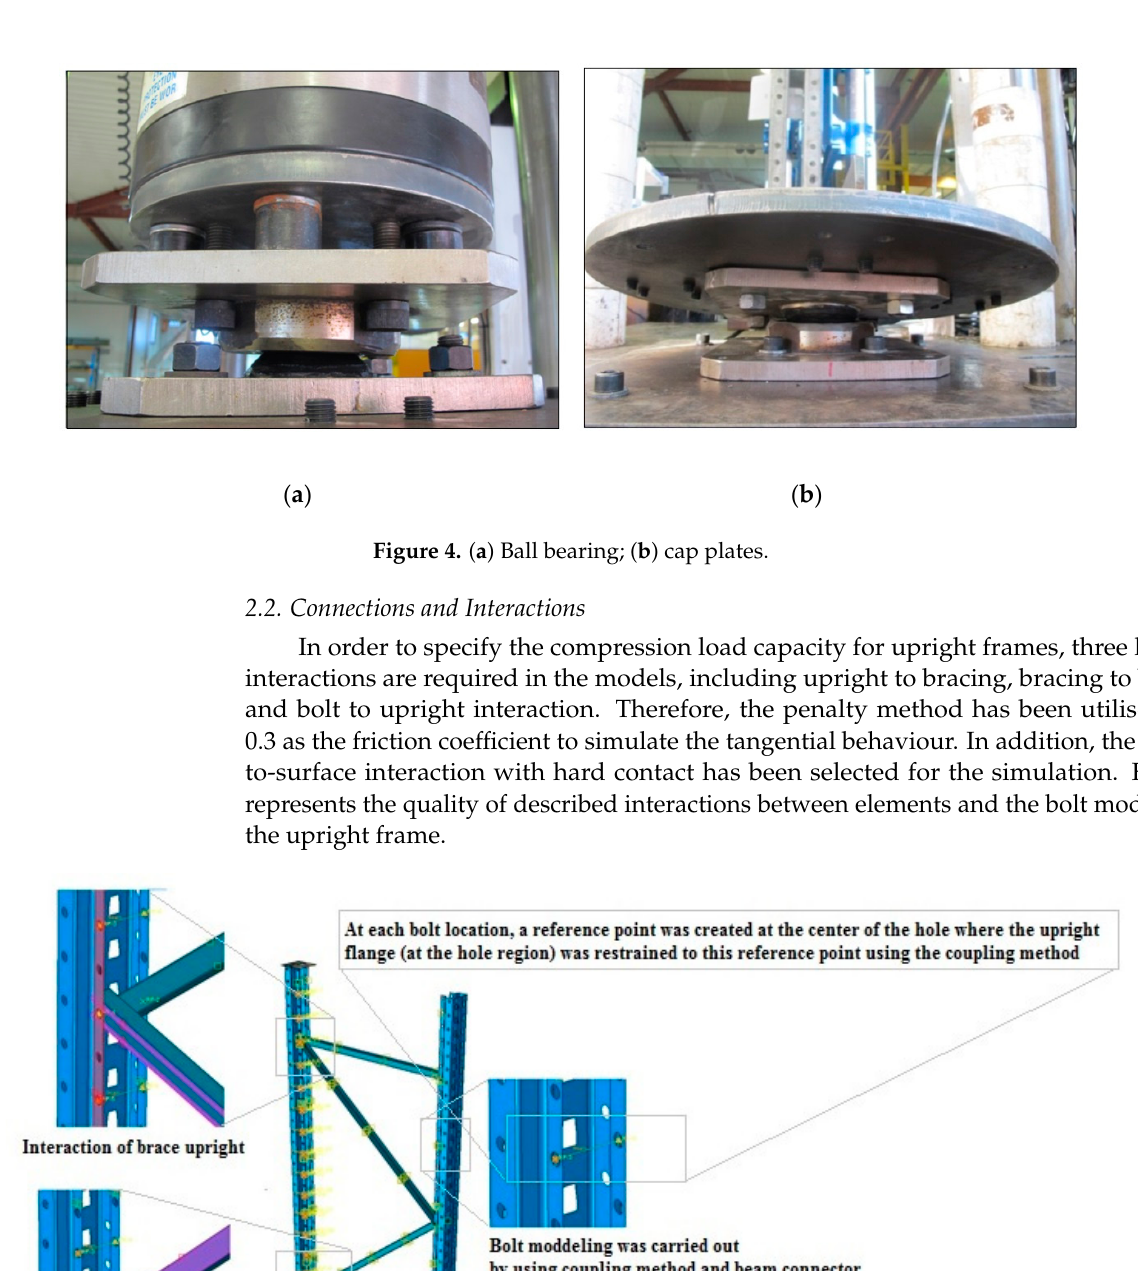
Figure 3 . ( a ) Schematic of compressive test on uprights; ( b ) testing rig.